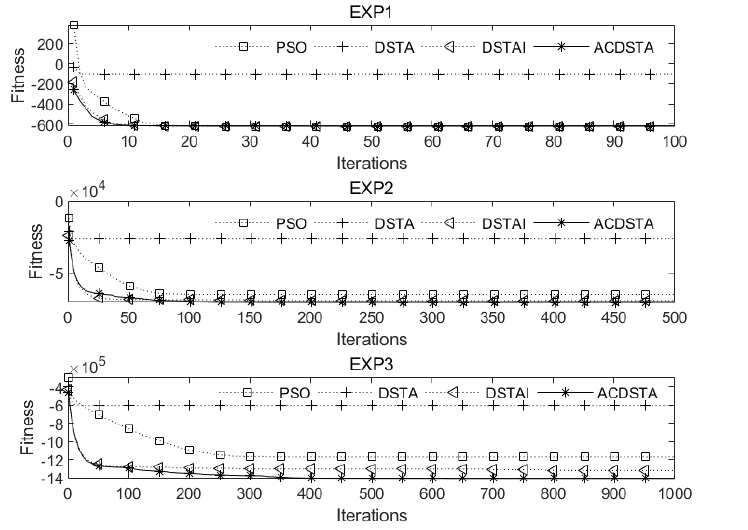
Figure 1. Convergencecurves of EXP1, EXP2, and EXP3 on four